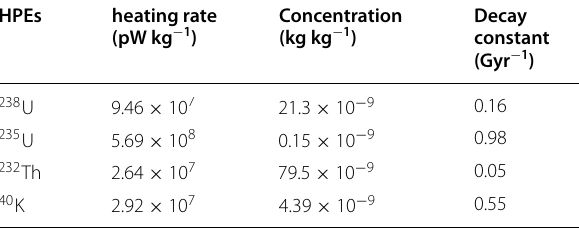
Heating rates and decay constants are after Turcotte and Schubert (2014). We assumed that the lunar bulk Th is the same as a value of the Earth (McDonough and Sun 1995; Tayor and Wieczorek 2014; Laneuville et al. 2018) and then, we estimated the K and U concentrations using the Th/U ratio (Lodders 2003) and K/ Th ratio (Tayor and Wieczorek